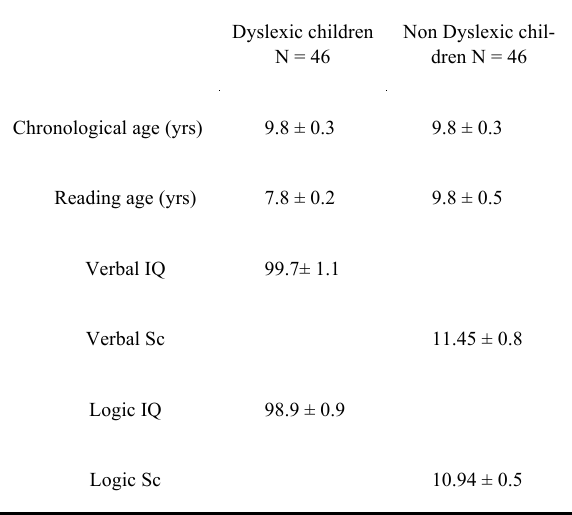
Table 1. Clinical characteristics of